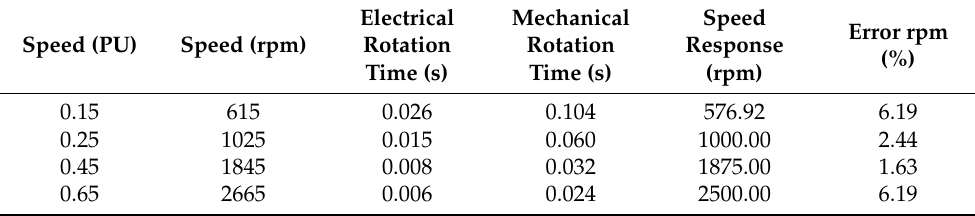
Table 3. Speed calculations from the rotor-position responses for the experimental platform. Speed